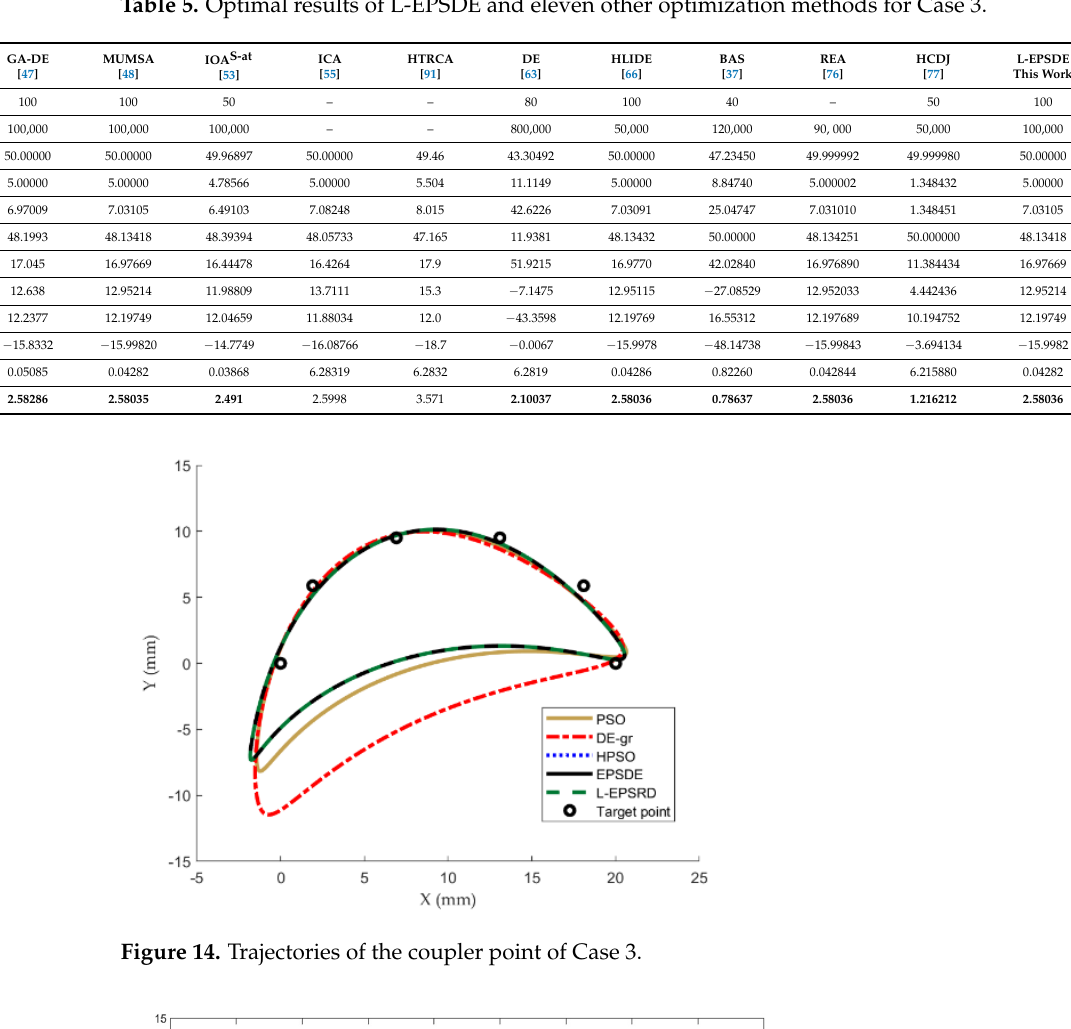
Table 5. Optimal results of L-EPSDE and eleven other optimization methods for Case 3.